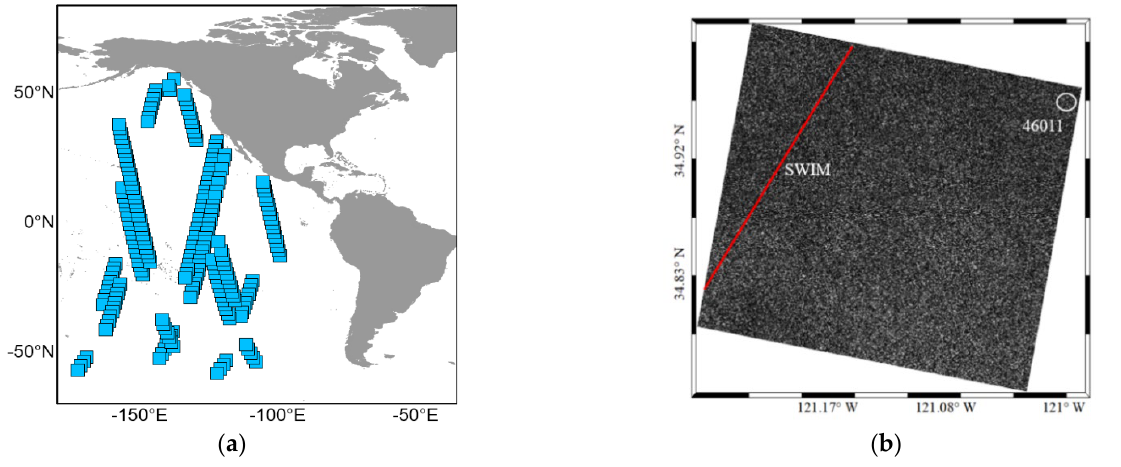
Figure 1. Data matching: ( a ) Distribution of matched data (S-1 SAR WV and CFOSAT SWIM) over a revisit period. ( b ) Position of Buoy 46011 and SWIM in SAR image.